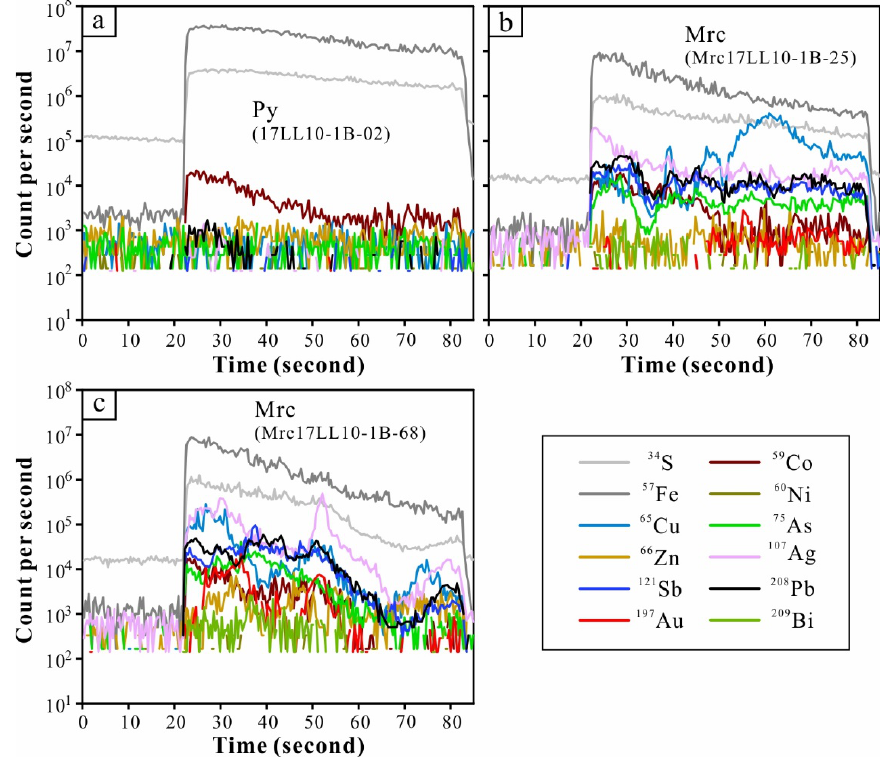
Figure 6. The LA–ICP–MS signals of selected elements in pyrite ( a ) and marcasite ( b , c ).